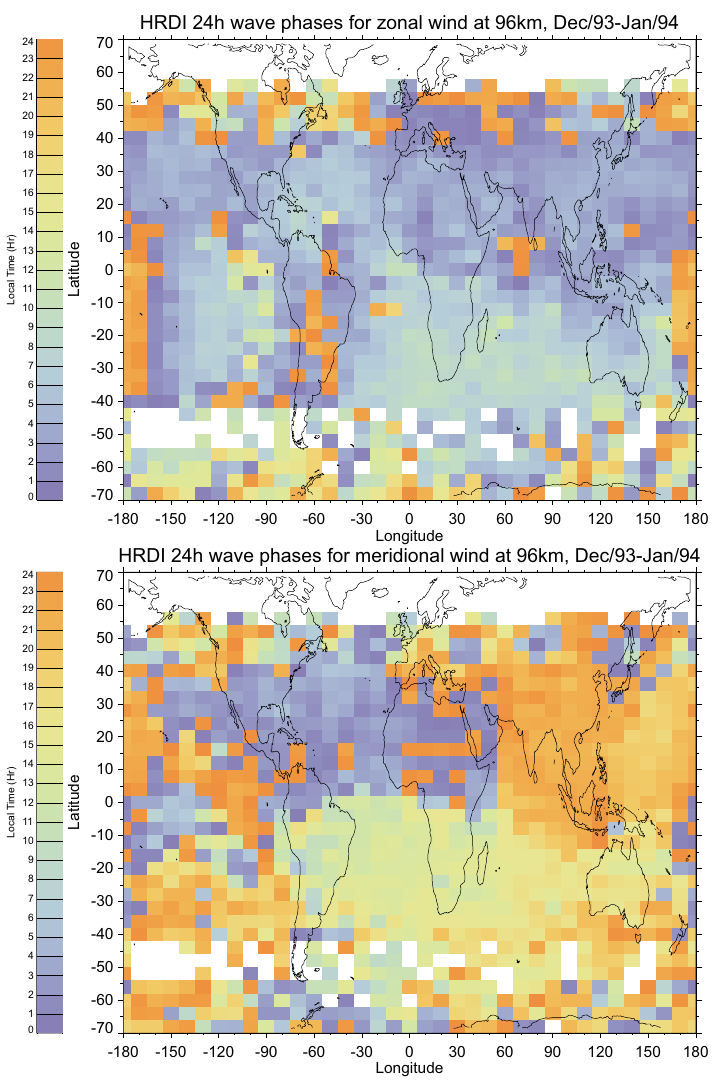
Fig. 4. Contoured plots of 24-h tidal phases for December 1993–January 1994 from